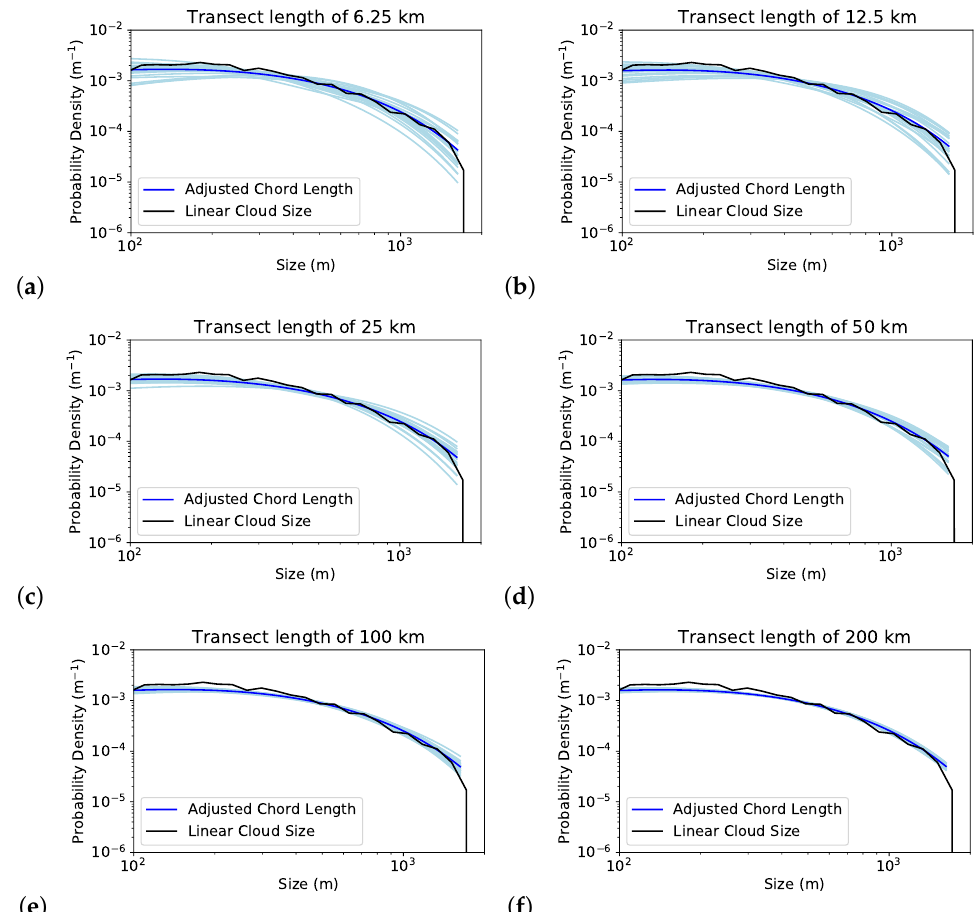
Figure 9. Reconstructed linear cloud size distributions for different transect lengths, with the linear cloud size (black), the mean adjusted chord length distribution (blue), and the adjusted chord length distribution of individual transects (light blue) for transects of ( a ) 6.25 km, ( b ) 12.5 km, ( c ) 25 km, ( d ) 50 km, ( e ) 100 km, and ( f ) 200